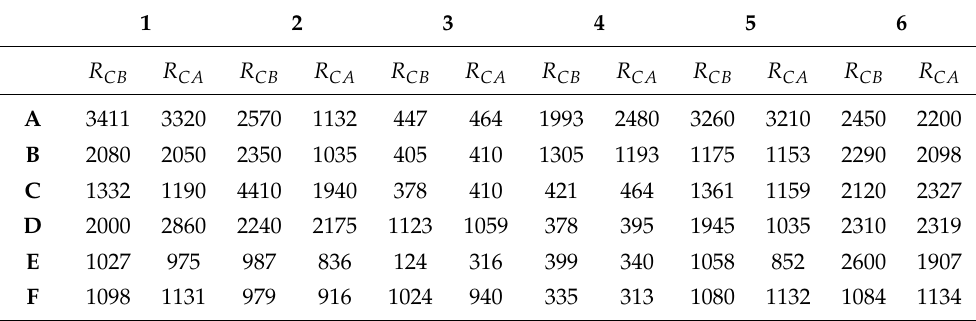
Table 3. Electrical resistance values of soil under controlled conditions for mapping level of soil